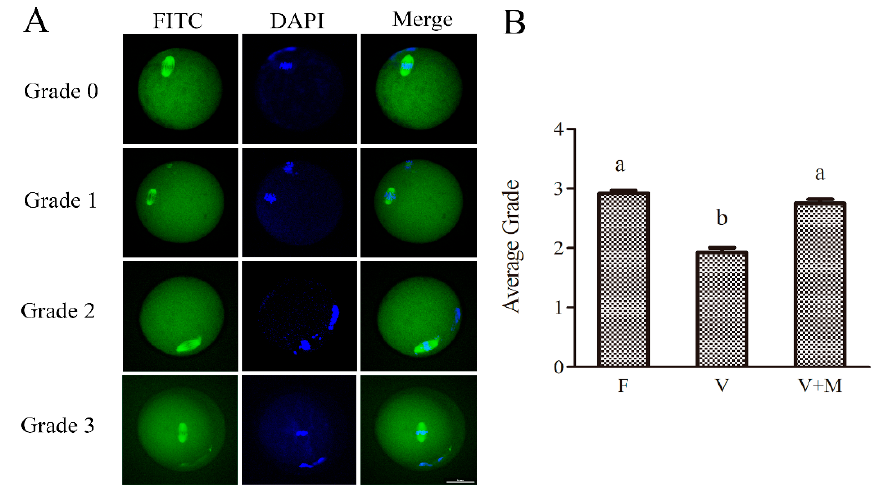
Figure 5. Effects of melatonin (MT) on spindle morphology of vitrified-warmed GV mouse oocytes during in vitro maturation. Spindle morphology scores were assessed in GV oocytes maturing to MII stage. ( A ): Grades of spindle morphology. Fresh control (F), vitrification (V), and vitrification + MT (V + M). Grade 0 = severely diminished spindle, i.e., that is less than 50% of the normal spindle in size. Grade 1 = mildly diminished spindle, i.e., larger than 50% of the normal spindle. Grade 2 = severely increased spindle i.e., larger than the normal spindle in size. Grade 3 = equivalent to the normal spindle in size and shape. Scale bar = 20 µm. ( B ): Average grade of spindle morphology in different groups. In total, GV oocytes were used in this assay n = 220 (F: n = 58; V: n = 87; V + M: n = 75). Data are presented as mean ± SEM of three independent experiments. Values with different superscripts (a, b, and c) are significantly different ( p < 0.05).